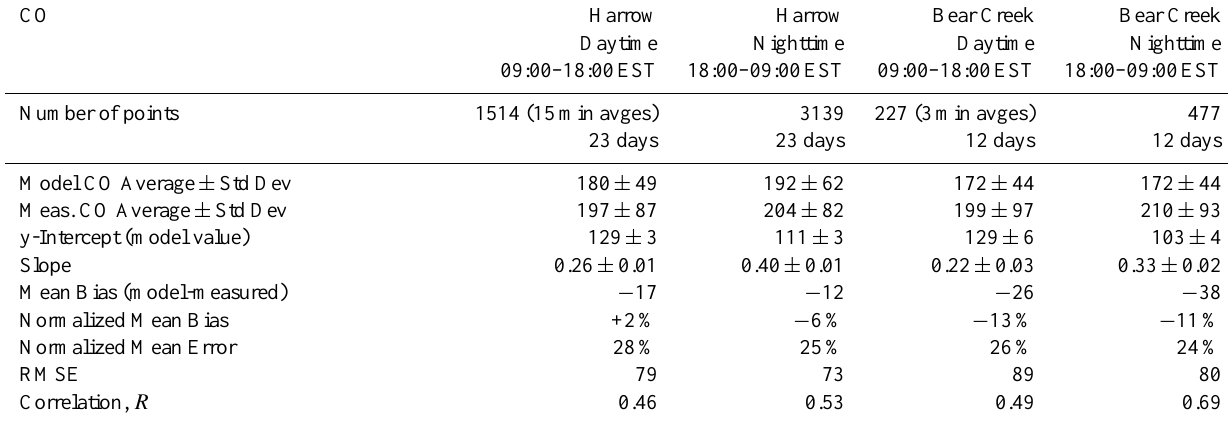
Table 8. AURAMS CO model performance statistics for the 2.5-km grid for the rural Harrow and Bear Creek sites (concentrations in